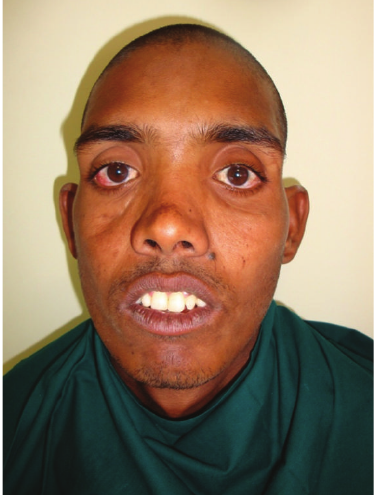
Figure 4: Postoperative 1